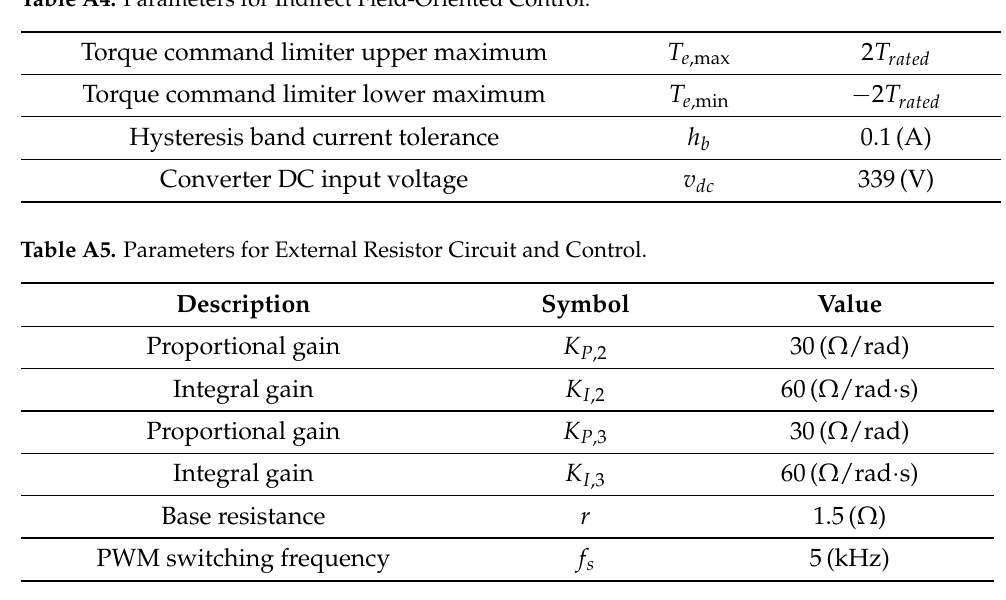
Table A4. Parameters for Indirect Field-Oriented Control.